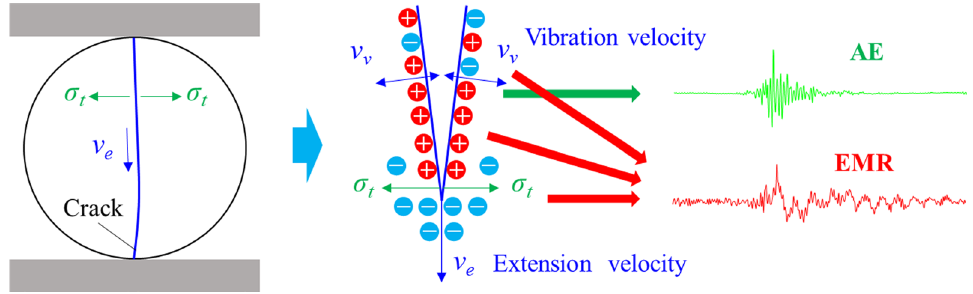
Fig. 11 Schematic diagram of AE and EMR induced by coal crack propagation (Qiu et al. 2022)